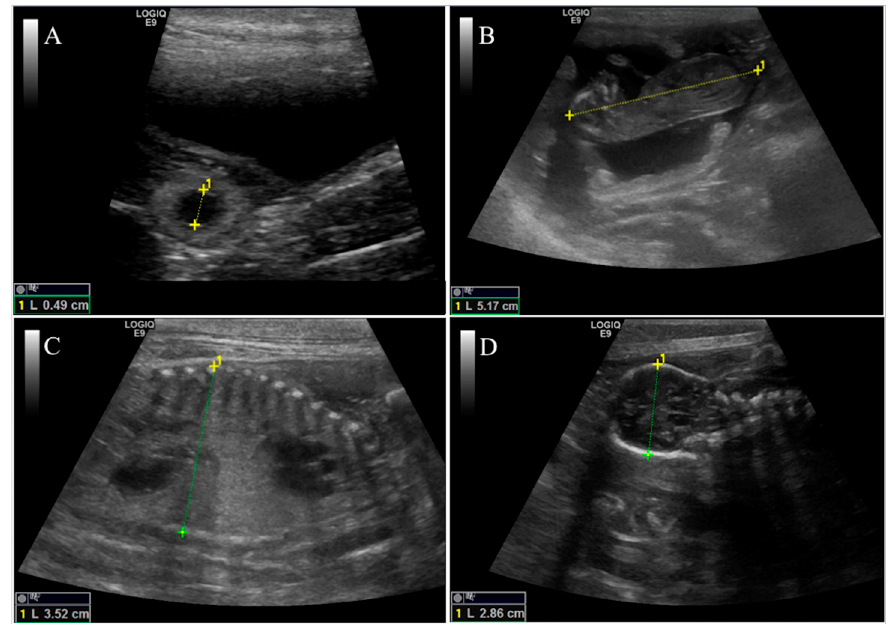
Figure 1. Representative ultrasonographic scans of biometry measurements recorded during preg- nancy in an Argentine Dogo. ( A ): inner chorionic cavity diameter at 23 days of pregnancy. ( B ): crown-rump length (distance from the top of the head to the base of the tail) at 40 days of gesta- tion. ( C ): body diameter in the transverse plane at the level of fetal liver at 53 days of gestation. ( D ): biparietal diameter (distance between parietal bones) at 57 days of pregnancy.